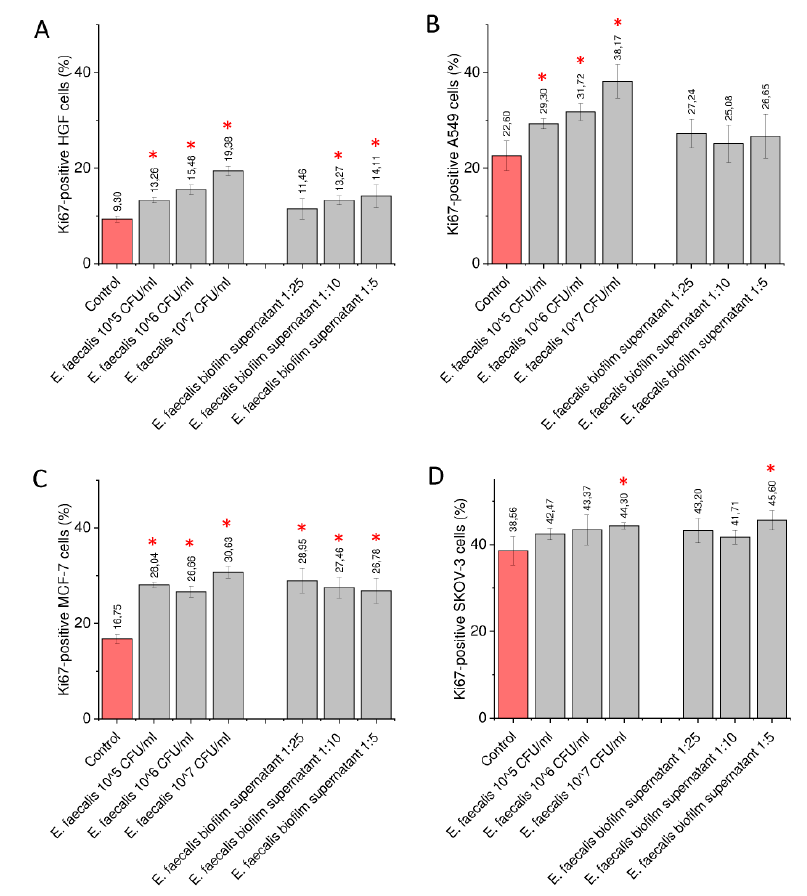
Figure 4. Impact of heat-inactivated E. faecalis and bacteria biofilm-derived supernatant on expression of Ki-67 protein in tested cell lines. Alterations in Ki-67 protein expression in human primary gingival fibroblasts (HGF) (panel A ), lung carcinoma A549 (panel B ), breast cancer MCF-7 (panel C ), and ovarian carcinoma SKOV-3 (panel D ) cells upon stimulation with heat-inactivated E. faecalis ATCC 29212 at concentrations of 10 5 , 10 6 , and 10 7 CFU / mL and biofilm-derived supernatant diluted 5, 10 and 25-fold in culture medium. Results are presented as mean ± SD from 3 individual measurements. * indicates statistical significance ( p < 0.05) compared to unstimulated control cells.